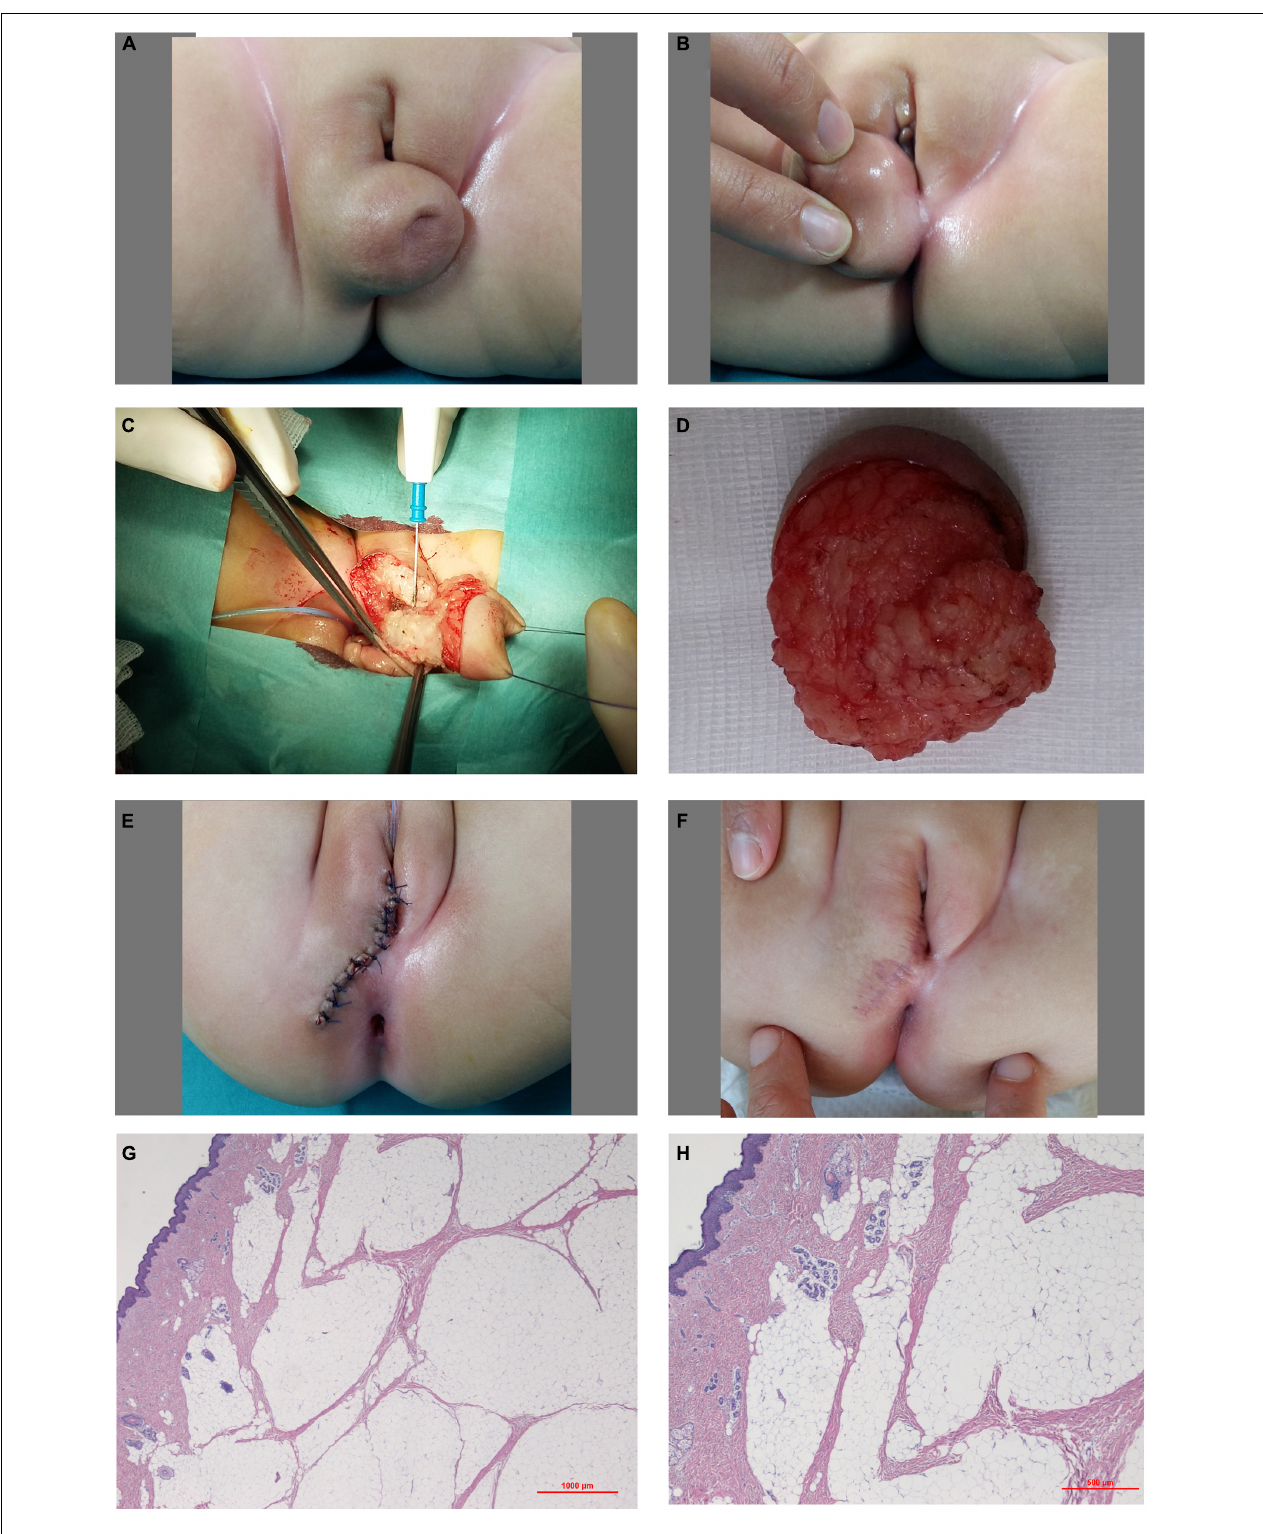
FIGURE 2 | Case 2. (A,B) Soft and spherical mass arising from the caudal aspect of the right labium major and from the perineum with a hollow and wrinkled skin area on its center side. (C) Surgery: excision of the mass. (D) Surgical specimen. (E) Perineal and labium skin closure through interrupted resorbable stitches. (F) One-month follow-up. (G,H) Histological examination: abundant mature adipose fat cells and superficially intra-lesional entrapped adnexal structures.